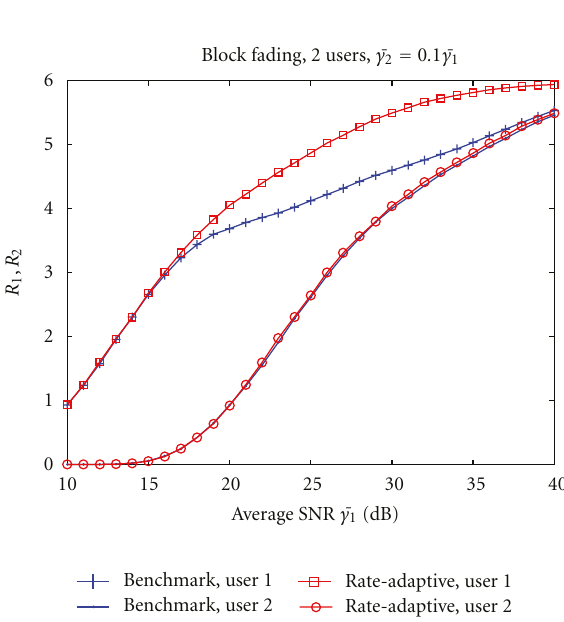
Figure 11: Comparison of the rates of two nodes belonging to a Network Coding group with M = 2 nodes in both AIR and CIR systems. One of the nodes su ff ers from a higher path loss attenuation (10dB) with respect to the other. Node with better channel in AIR system achieves higher rate with respect to node with better channel in CIR system. The gain arises from adapting the coding rate of each node to the channel independently from the other